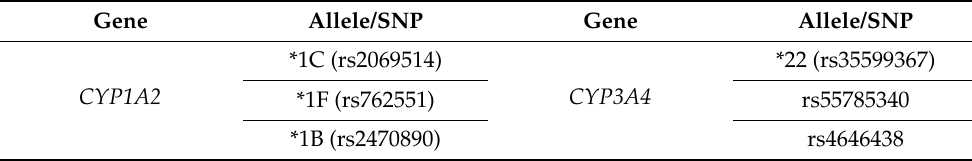
Table 1. Variants/alleles* genotyped with the Open Array/QuantStudio 12k flex platform.